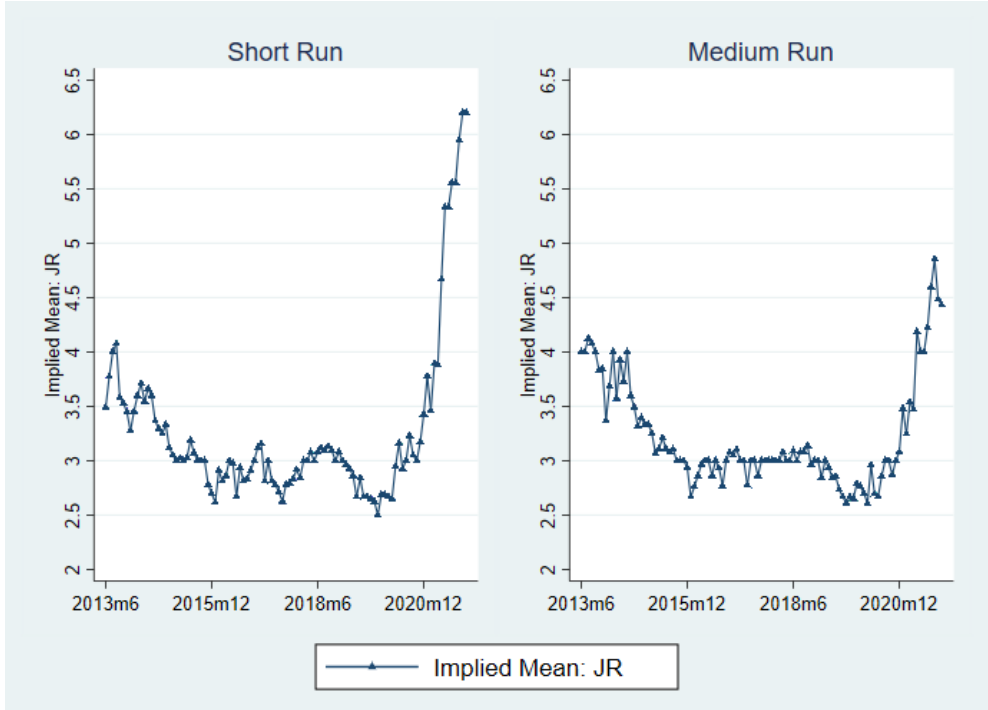
Figure 1. The figure shows the survey-interpolated medians of the distribution implied means for each short run and medium run inflation expectations. The means are calculated using the subjective probability distribution proposed in this